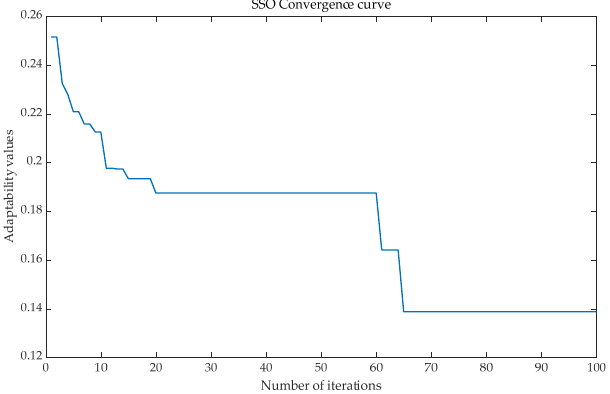
Figure 13. Convergence curve of SSO (PV Power). Table 5. Prediction results evaluation form (PV Power).